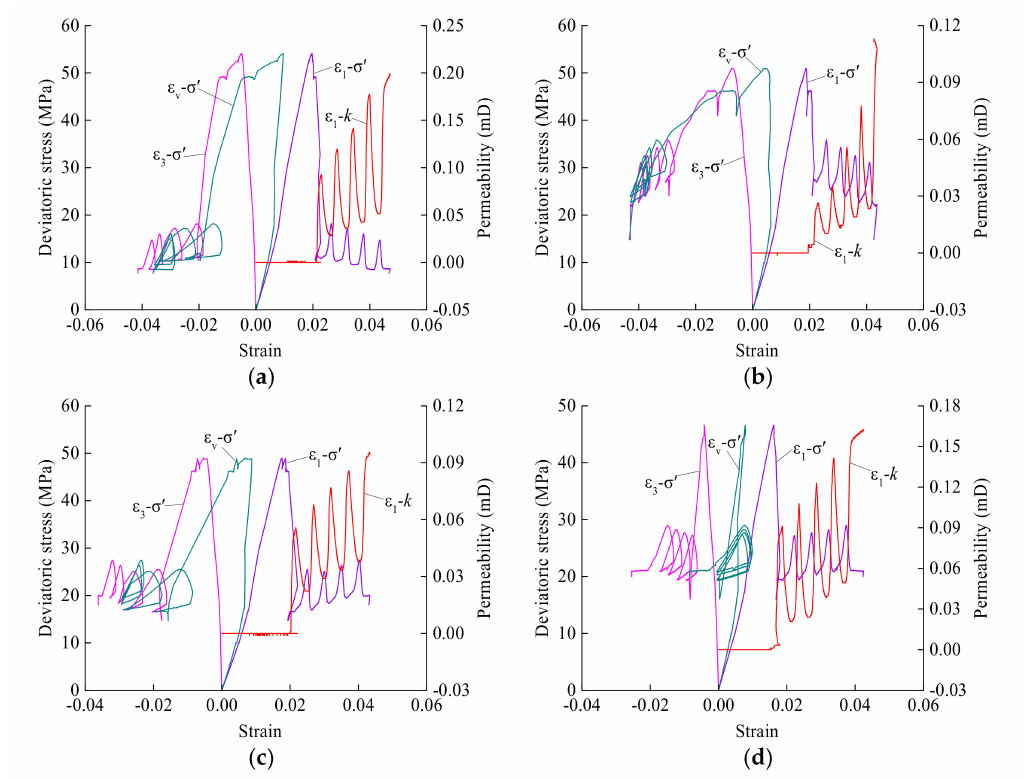
Figure 3. Deviation stress–strain-permeability curves of each sample under different water content conditions. ( a ) water content 0% ( b ) water content 0.15% ( c ) water content 0.32% ( d ) water content